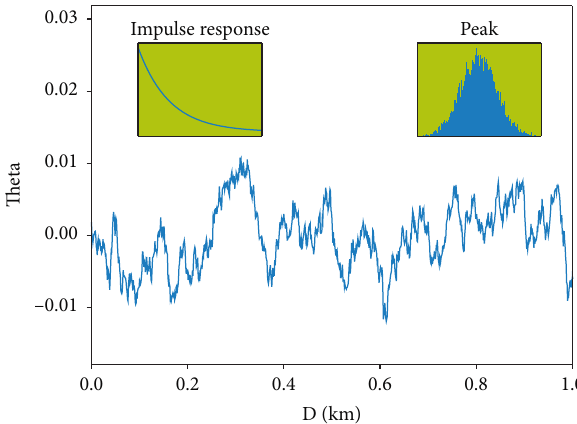
Figure 2: Adjustment factor